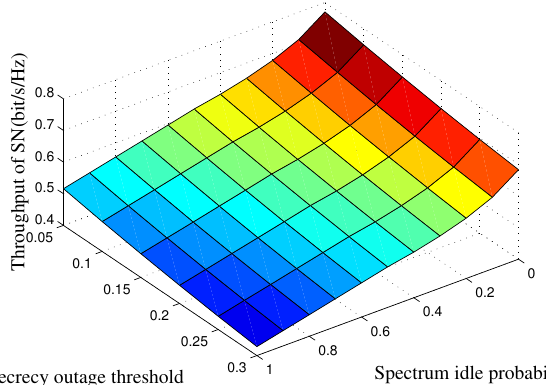
Figure 5. SN’s average throughput of the proposed strategy as a function of the target secrecy outage probability and spectrum idle probability. The transmit power of the PT is set to P b = 15 dB, and the spectrum sensing time is set to τ = 1